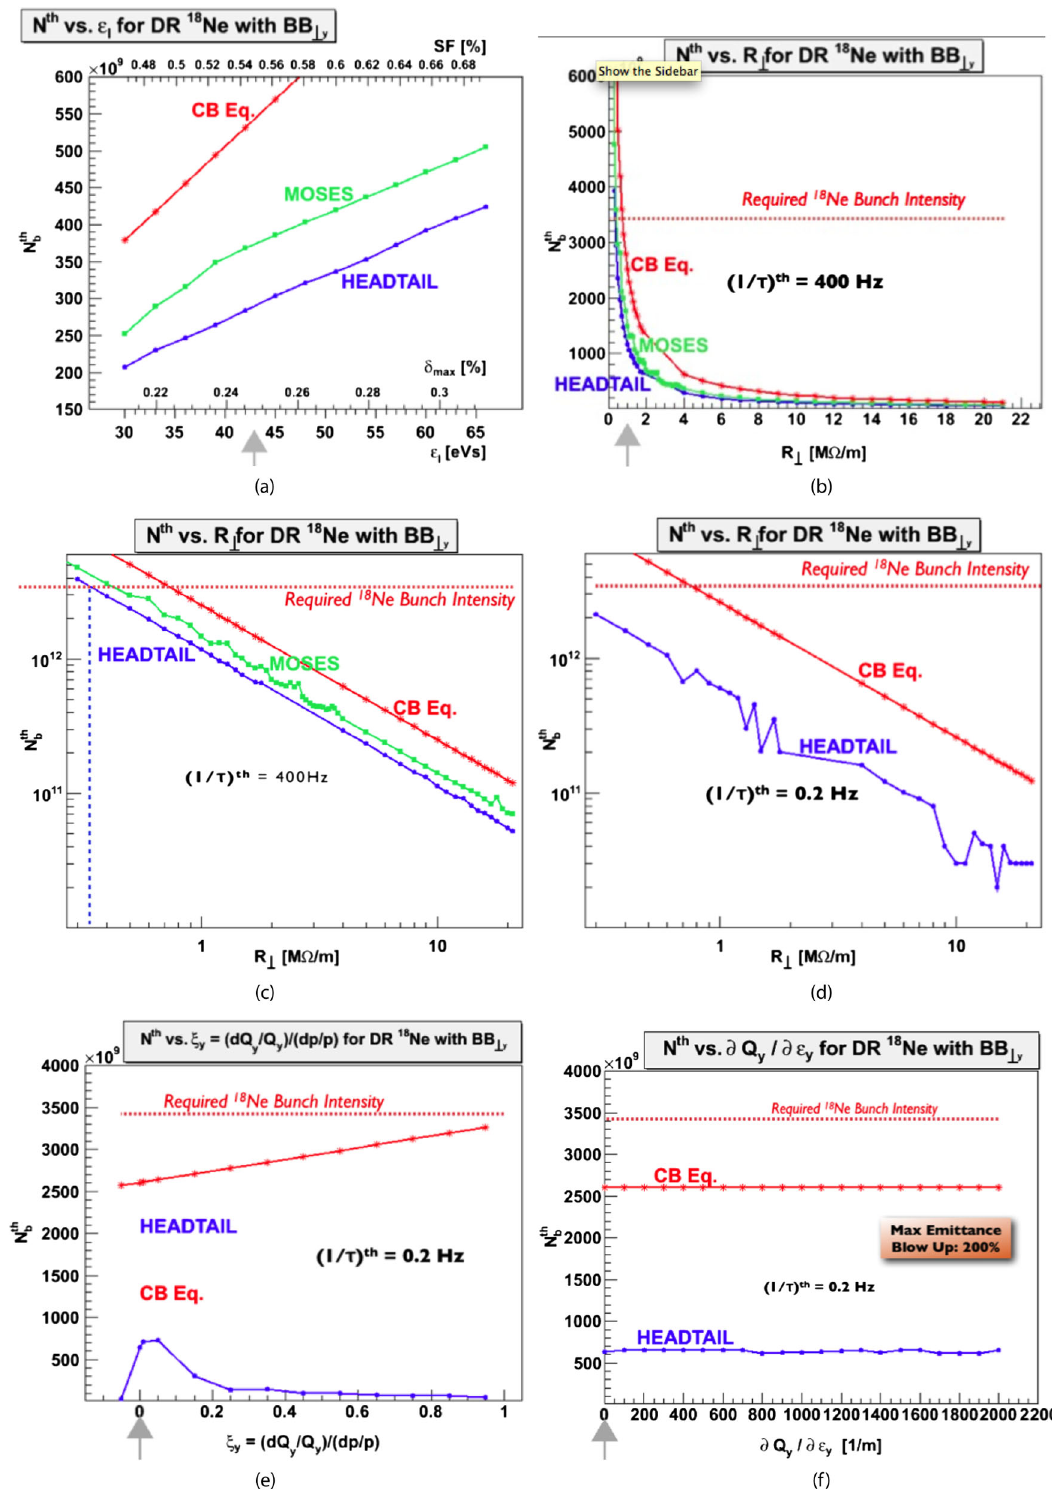
FIG. 49. N th as a function of (a) the longitudinal emittance and (b, c, d) the transversal shunt impedance according to the C.B. eq. (24), B 18 Ne, in the decay ring is shown. With the log-log scale in MOSES [125] and HEADTAIL [126]. Only the case for the neutrino emitter, (c) we see that R ⊥ < 0 . 2 M Ω = m is needed to allow 3 . 4 × 10 12 18 Ne per bunch. Instability dampings were attempted with chromaticity (e) and amplitude detuning (f), both without